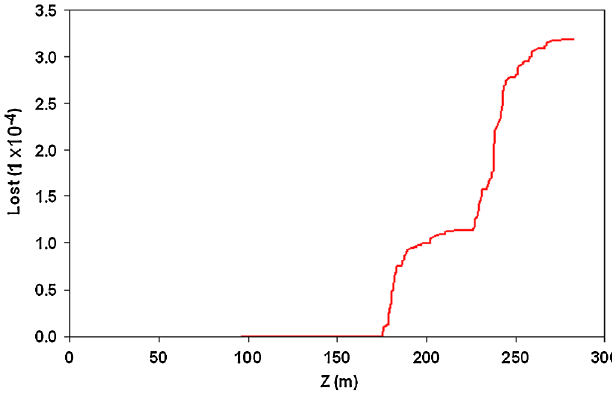
FIG. 6. (Color) Accumulated beam loss in the superconducting linac for 38 mA design beams and baseline linac lattice without error or misalignment, except dodecapole